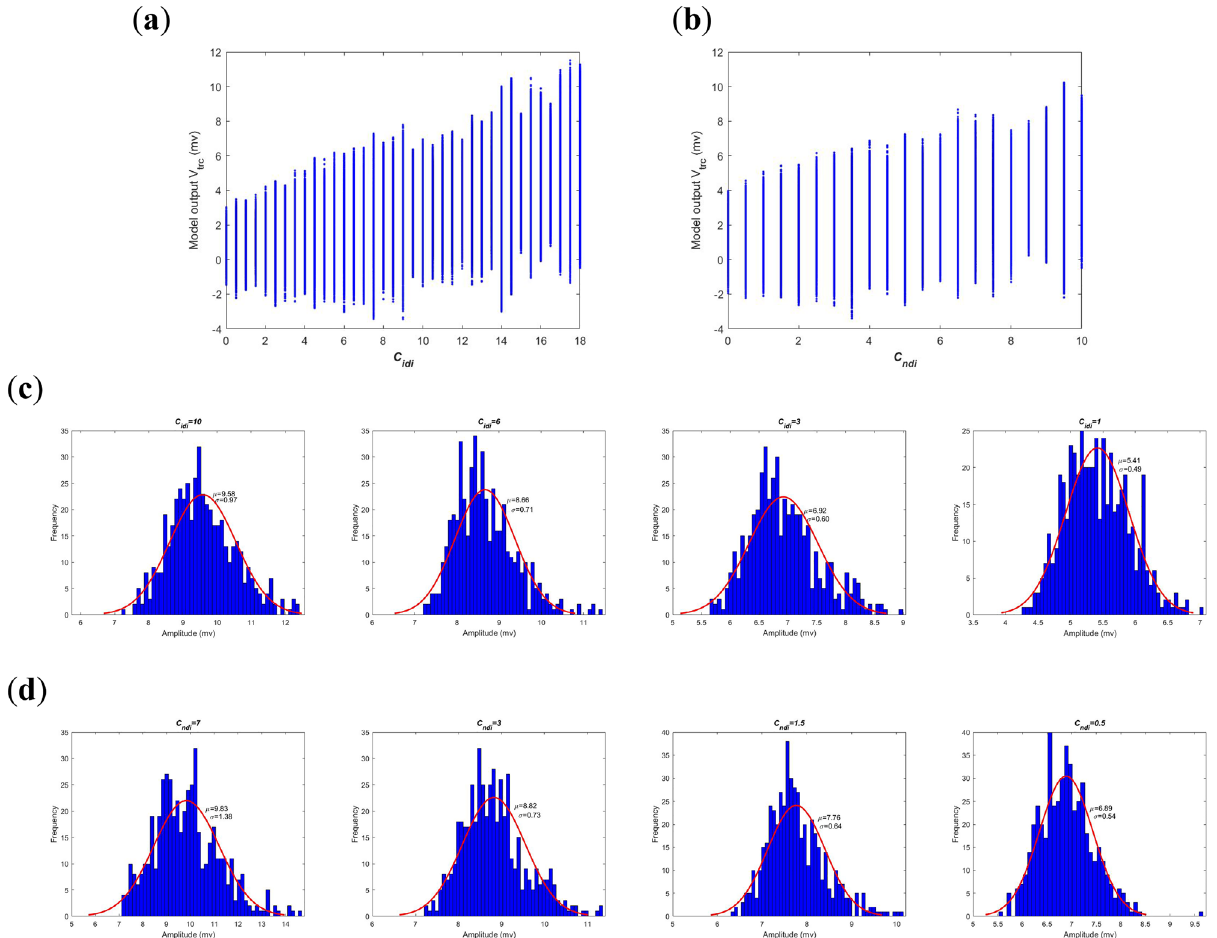
Figure 5. Amplitude analysis of the BTC model output V t in time domain with decreasing of inhibitory synapse connectivity parameters C idi from PNN to IN and C ndi from PNN to TRN. The model output of the summated postsynaptic potential V t for each C idi ( a ) and C ndi ( b ). Amplitude distribution of V t based on 500 simulation results for different C idi ( c ) and C ndi ( d